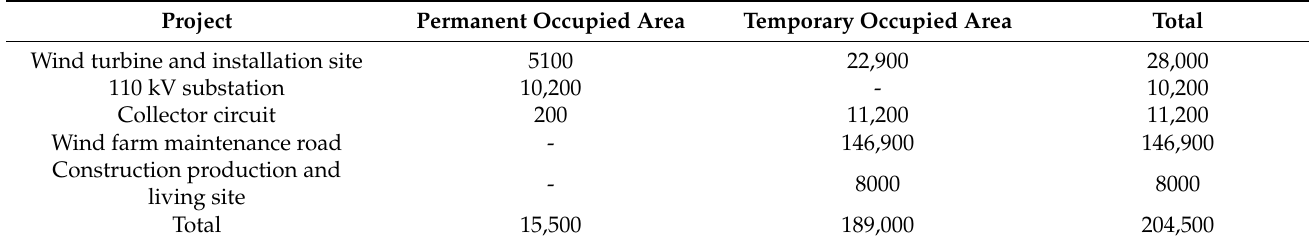
Table 6. Permanent and temporary site area (m 2 ).